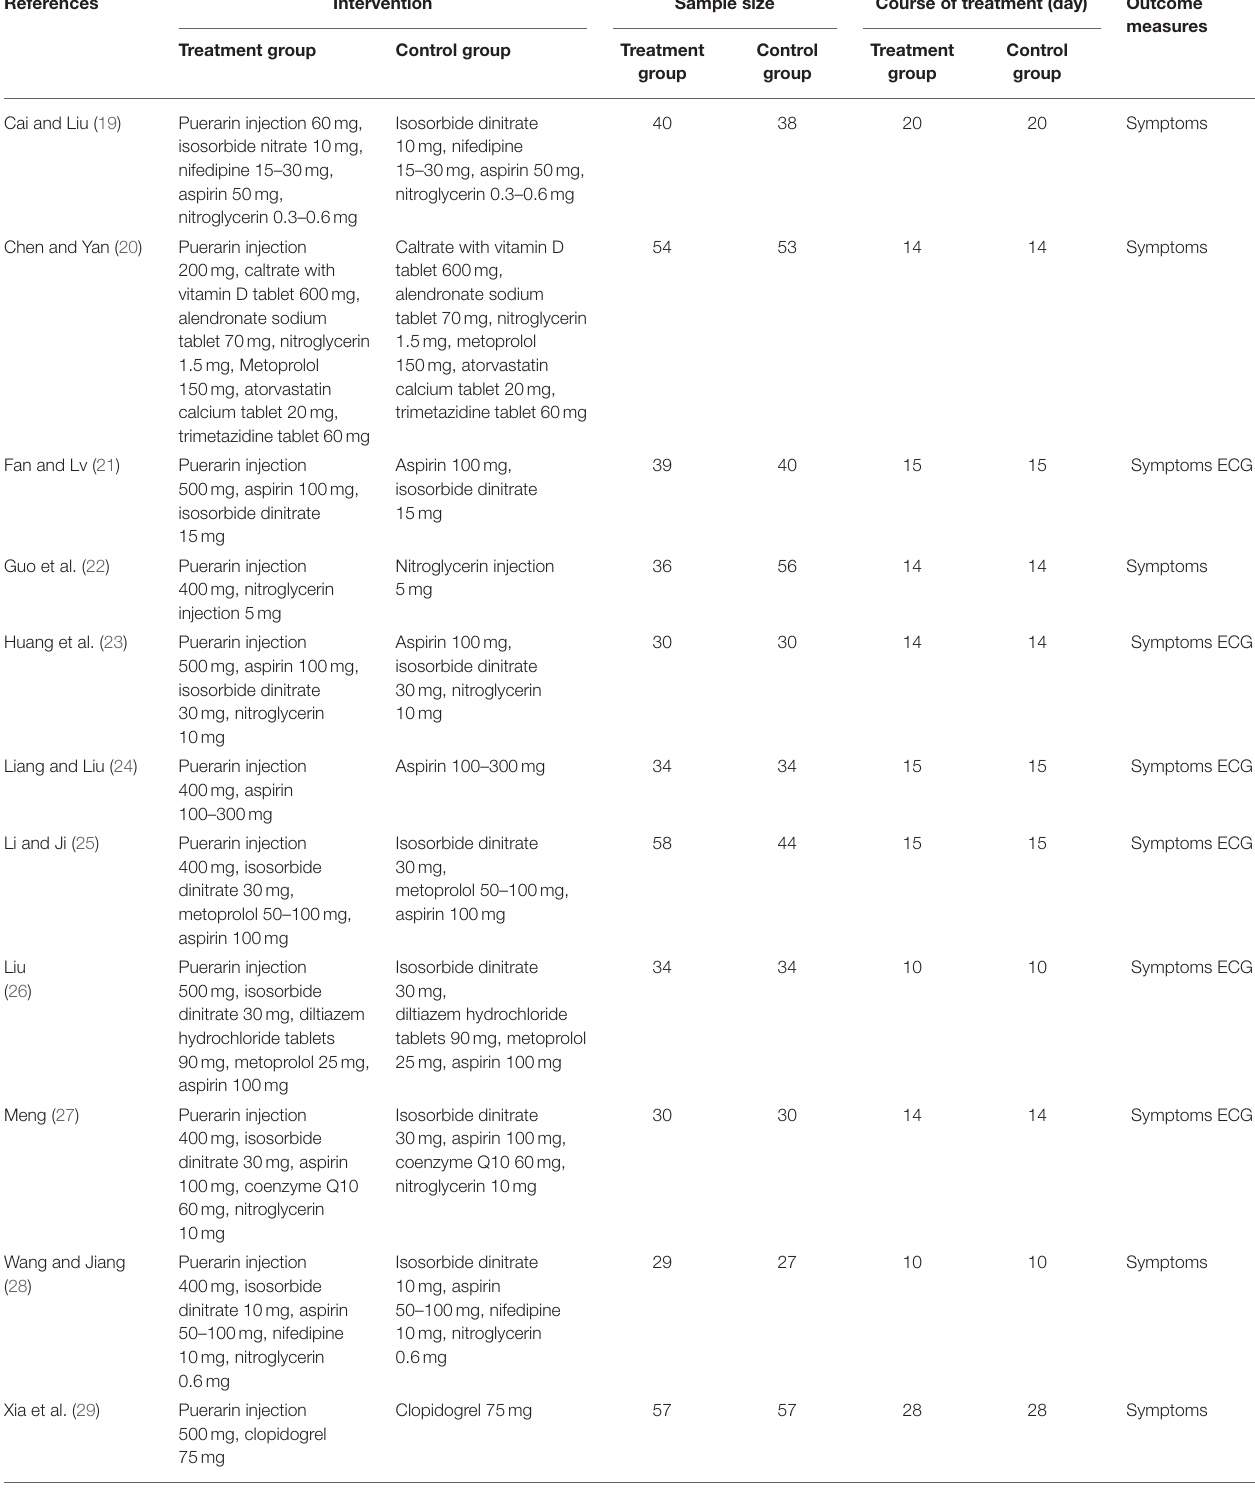
TABLE 1 | Characteristics of RCTs on puerarin injection for unstable anginal